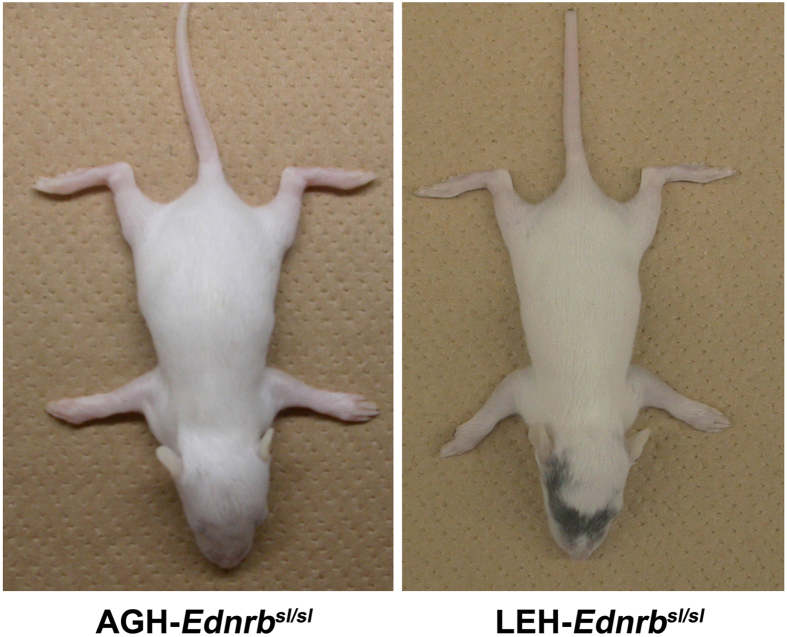
Comparison of the expressivity of the pigment disorder.In 14-day-old rats, no pigmentation on the head was observed in AGH-Ednrbsl/sl rats, and pigmentation was observed in LEH-Ednrbsl/sl rats.